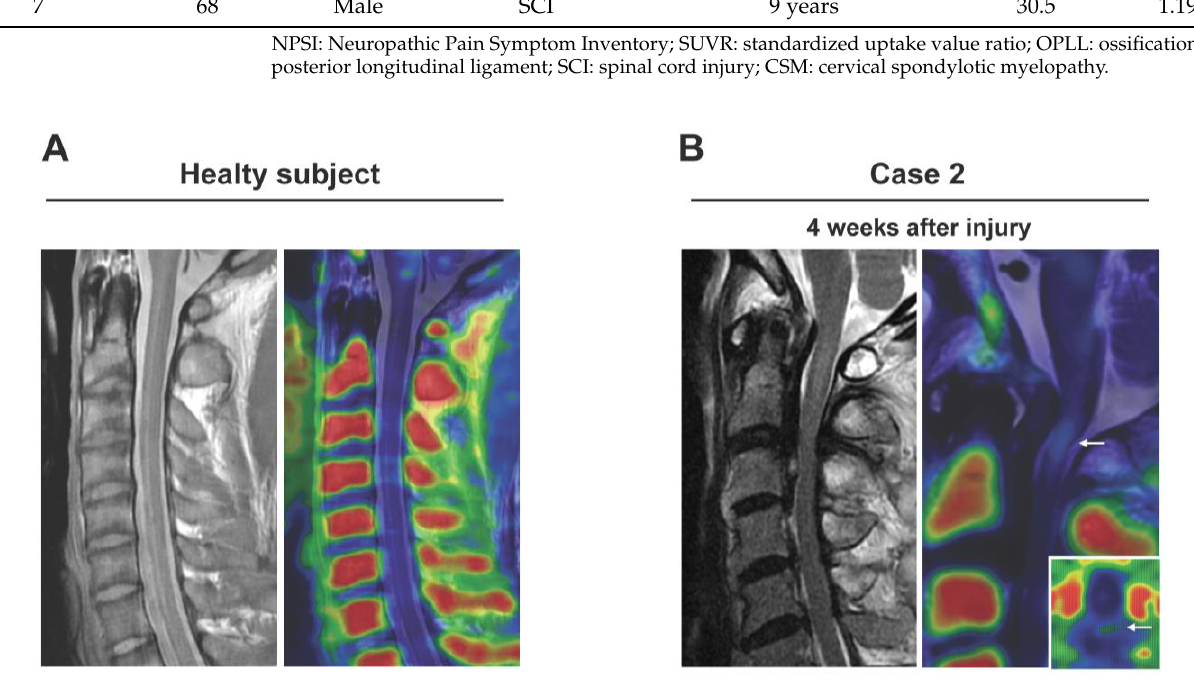
Figure 5. Clinical application of (R) -[ 11 C]PK11195 PET/3T-MRI for patients with neuropathic pain. Data are shown for a healthy subject ( A ) and in patients examined at 4 weeks ( B ), at 10 months ( C ), and 9 years ( D ) after surgery. (R) -[ 11 C]PK11195 uptake was apparent at 4 weeks and 10 months, but there was no significant (R) -[ 11 C]PK11195 uptake at 9 years, despite the patient having severe neu- ropathic pain.